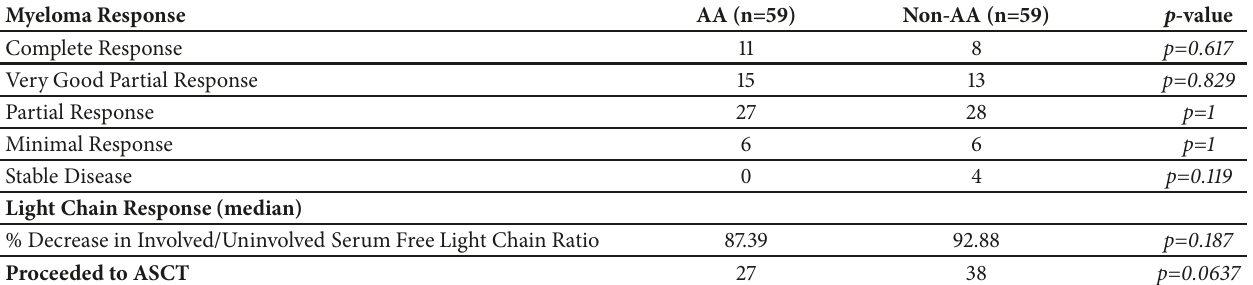
Table 4: Multiple myeloma response following initial